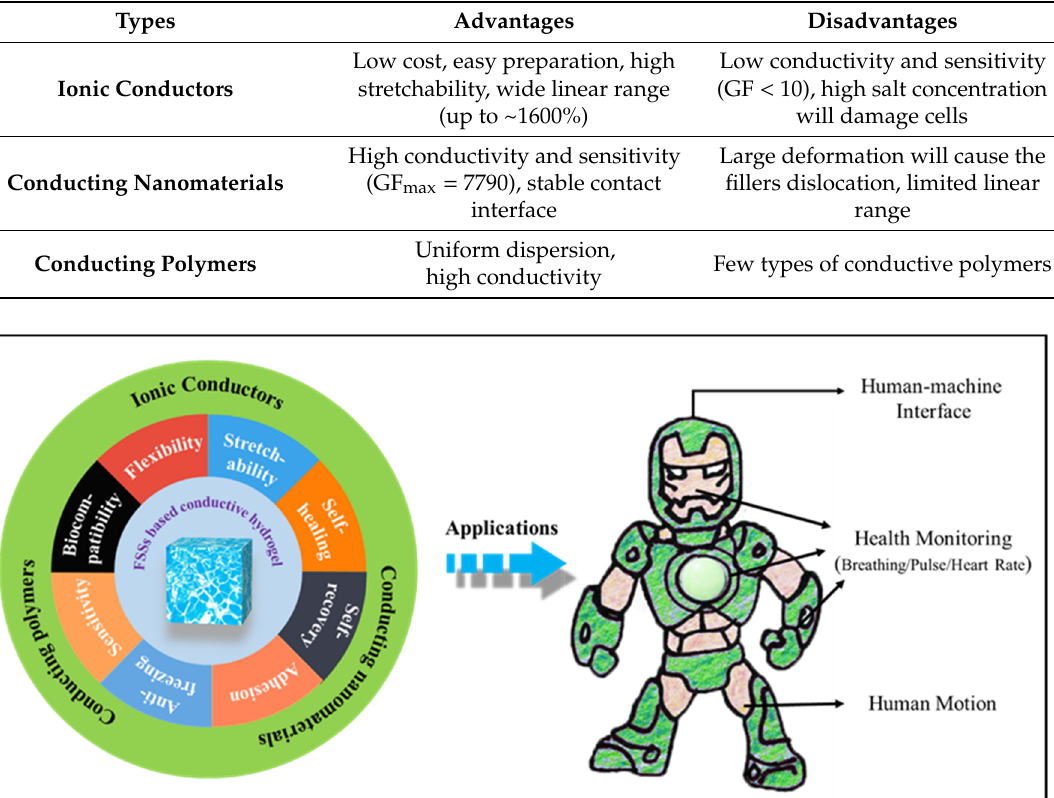
Table 2. Comparison of different types of conductive hydrogel .